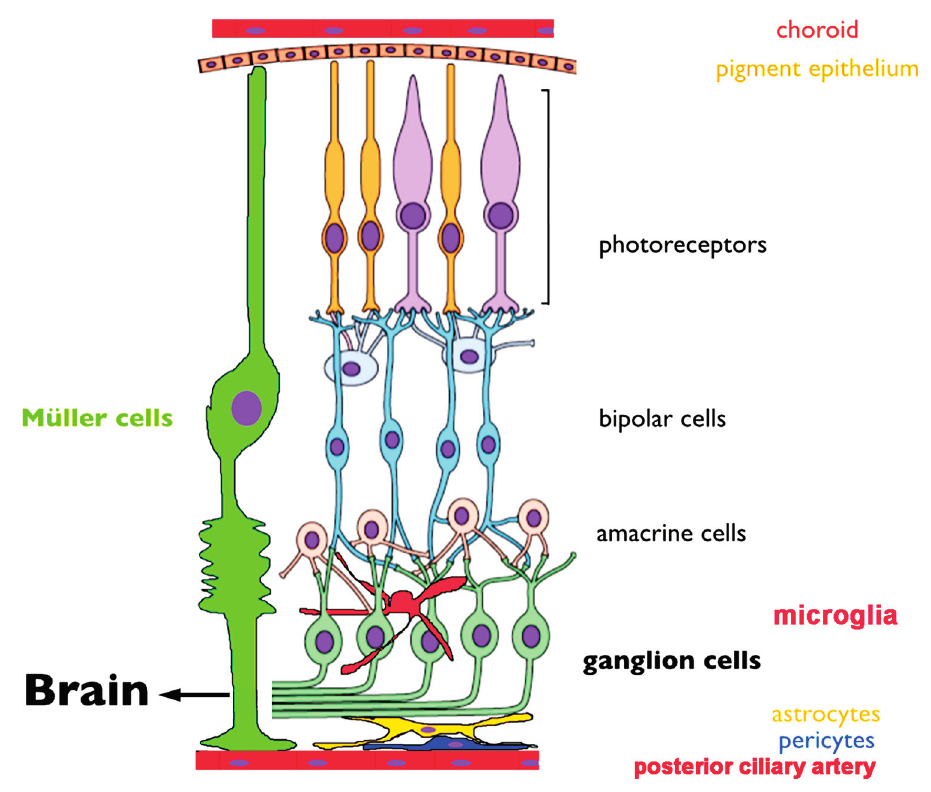
Figure 1. A schematic of the retina showing overall arrangement of retinal layers and relationship to the critical vascular and pigment layers. An excitatory vertical chain (photoreceptors, bipolar cells, ganglion cells) provides a direct route for transmitting visual information to the midbrain. Lateral inputs from horizontal cells and amacrine cells provide luminance gain control and organization spatiotemporal receptive fields of retinal neurons. Müller glia provide most of the functions performed by astrocytes in the brain. Astrocytes form the blood-retina barrier together with pericytes and vascular endothelial cells. Microglia play a role in developmental pruning and the retinal immune response whereas the choroid and posterior ciliary artery feed outer and inner retinal neurons, respectively. Adapted from